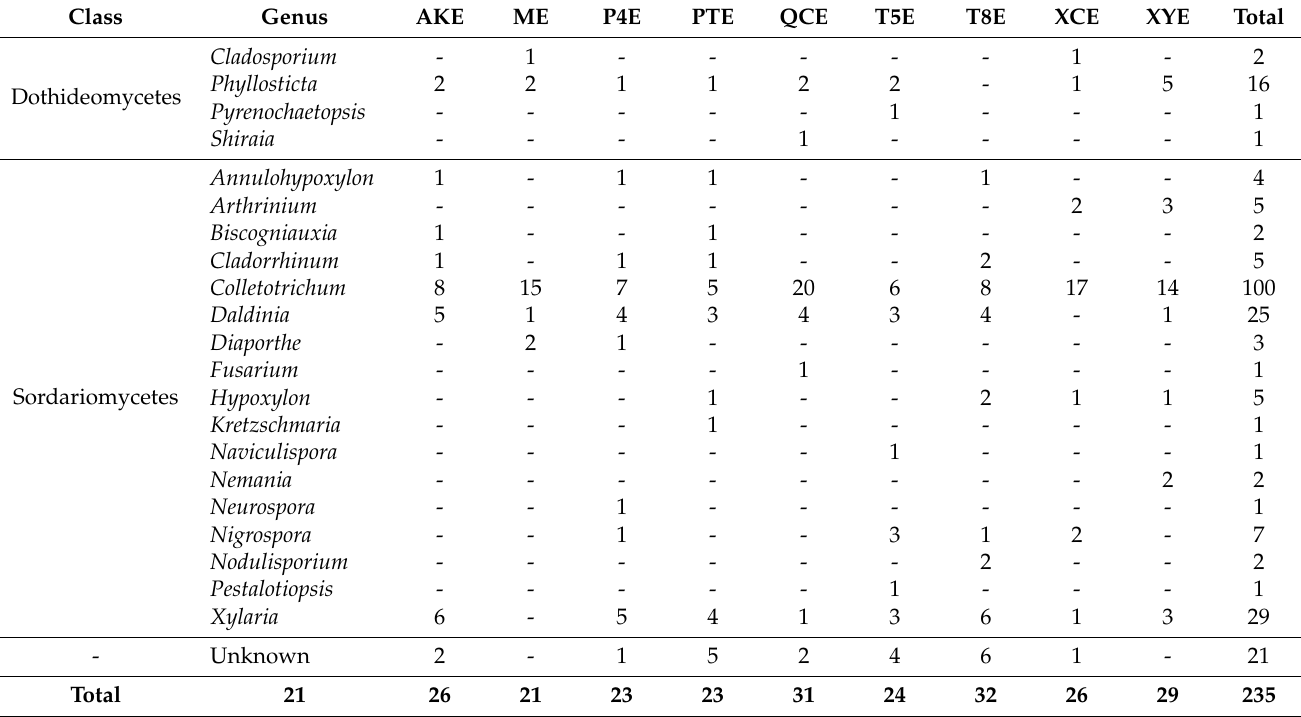
Table 2. Records of coffee leaf fungal